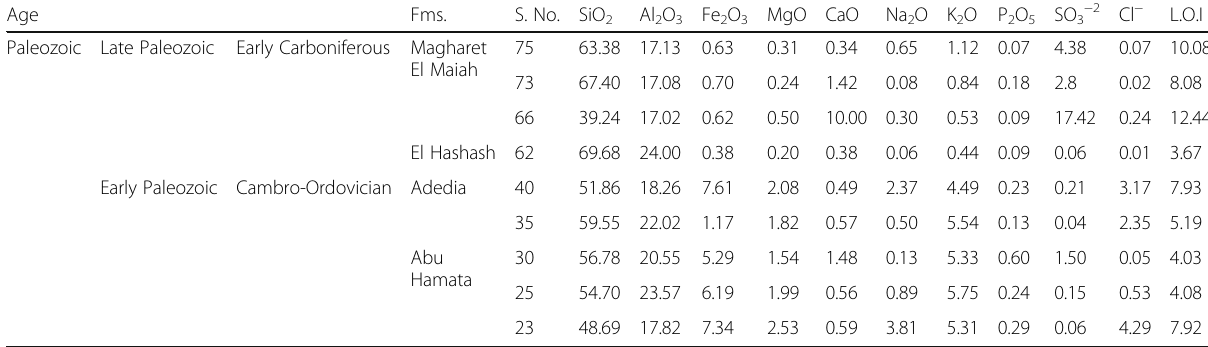
Table 2 Chemical composition (major components in Wt.%) of Paleozoic mudrocks Age Fms. S. No. SiO